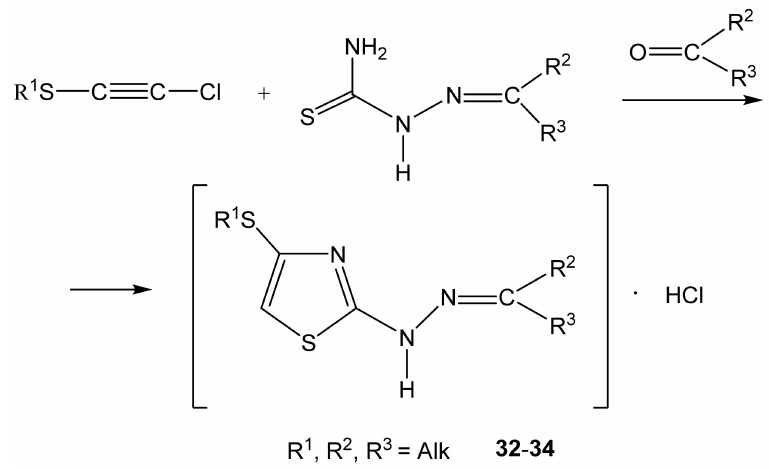
Figure 6. Calculated B3LYP/6-311++G(d,p) (GIAO) and experimental 13 C and 15 N NMR spectra of compound 32.